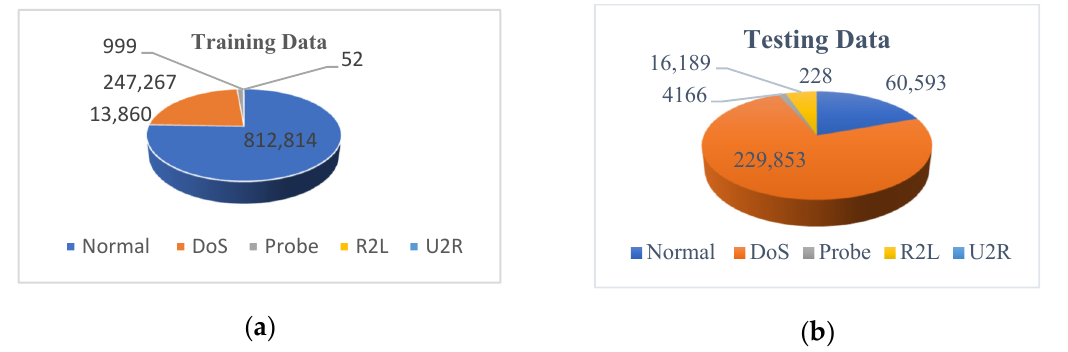
Figure 5. KDDCup 99 ( a ) training data and ( b ) testing data.